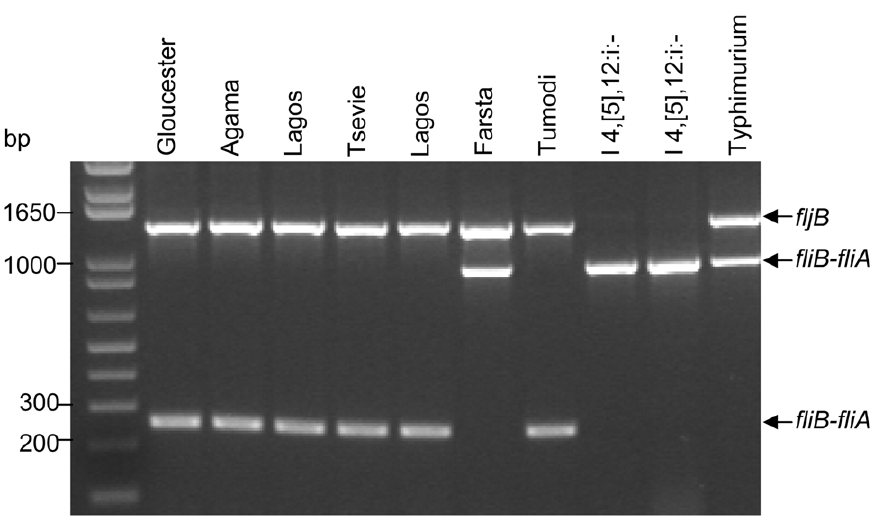
Figure 3. Differentiation of diphasic Salmonella Typhimurium and monophasic Salmonella Typhimurium from other H:i serovars. The PCR to discriminate between Salmonella Typhimurium and I 4,[5],12:i:- strains was validated using nine reference Salmonella O group B, H:i isolates of various serovars. doi:10.1371/journal.pntd.0000621.g003 amplification method (different polymerases and cycling condi- tions were used).